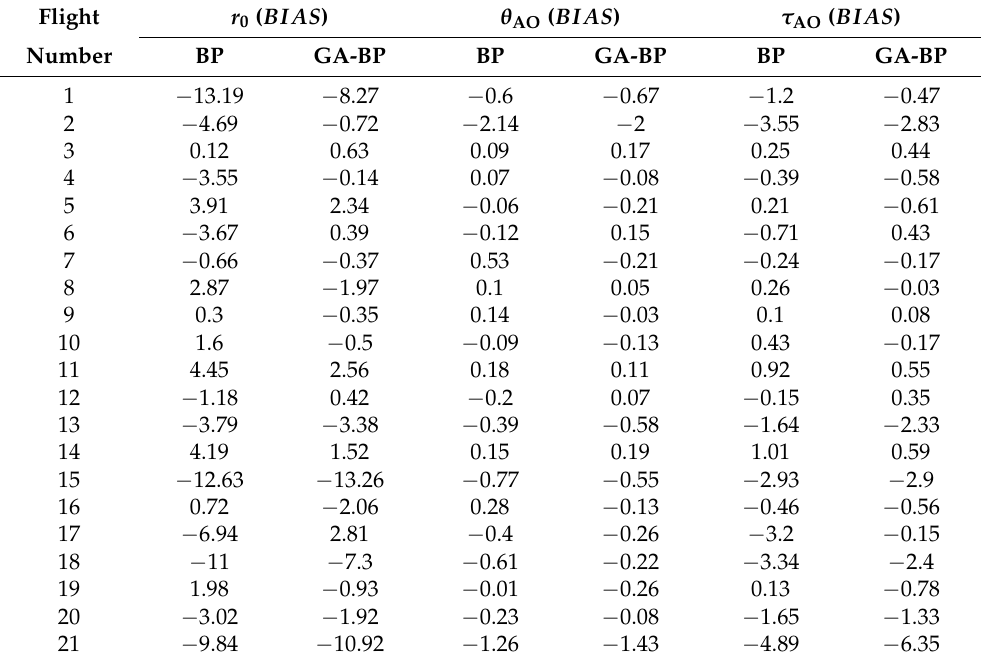
Table 3. Comparison of integrated parameters between GA-BP and BP models. BIAS = Model −